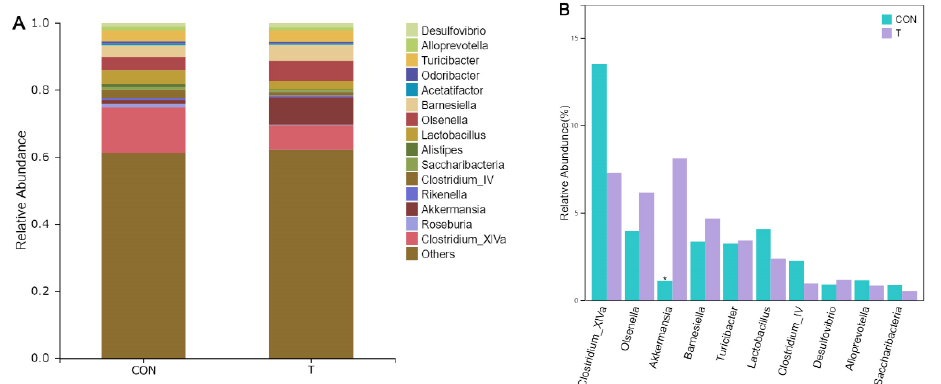
Figure 10. ( A ) Comparison of intestinal bacteria species distribution in mice at genus level; ( B ) Com- parison of intestinal bacteria species classification in mice at genus level. * indicates significant difference between groups ( p < 0.05), and no * indicates no significant difference ( p > 0.05).